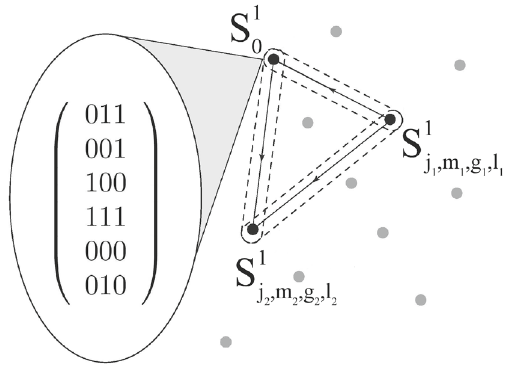
Fig. 3 A correlation of three base-two sequences, which is a base-8 sequence and an element of S 3 ( n ) , can be visualized as a directed graph with three vertices and three directed edges. Among the rules governing thequantumnumbersassociatedwiththisgrapharethoseforinteracting spin systems in QM. For the case shown here, the quantum numbers are j 10 = 3 , m 10 = − 1 , g 10 = 3 , l 10 = + 1 , j 02 = 1, m 02 = 0, g 02 = 2 2 2 2